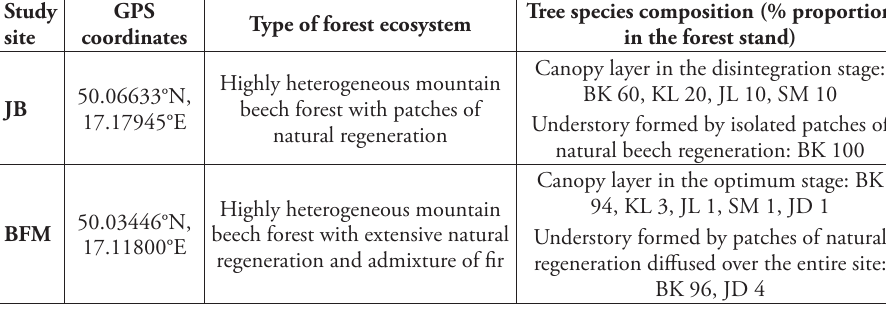
Table 1. Forest stand characteristics for the Jeleni Bucina ( JB ) and Bucina pod Frantiskovou Myslivnou ( BFM ) study sites as used for the growth simulation